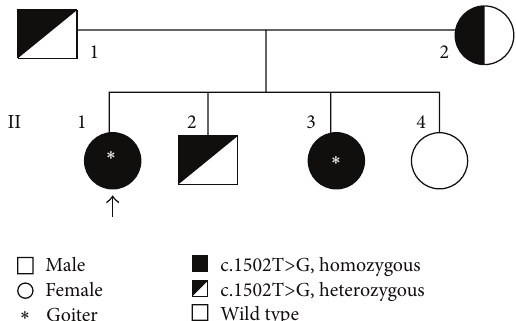
Figure 2: Family pedigree of the index patient. A family pedigree of two sisters with congenital hypothyroidism and multinodular goiter. The proband is indicated by an arrow. N/A: data are not available; TSH: thyrotropin; TT 4 : total thyroxine; FT 4 : free thyroxine; Tg,